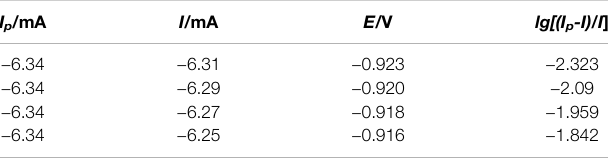
TABLE 1 | Calculated data related to any four points in the cyclic voltammetric curve (30 mV/s).